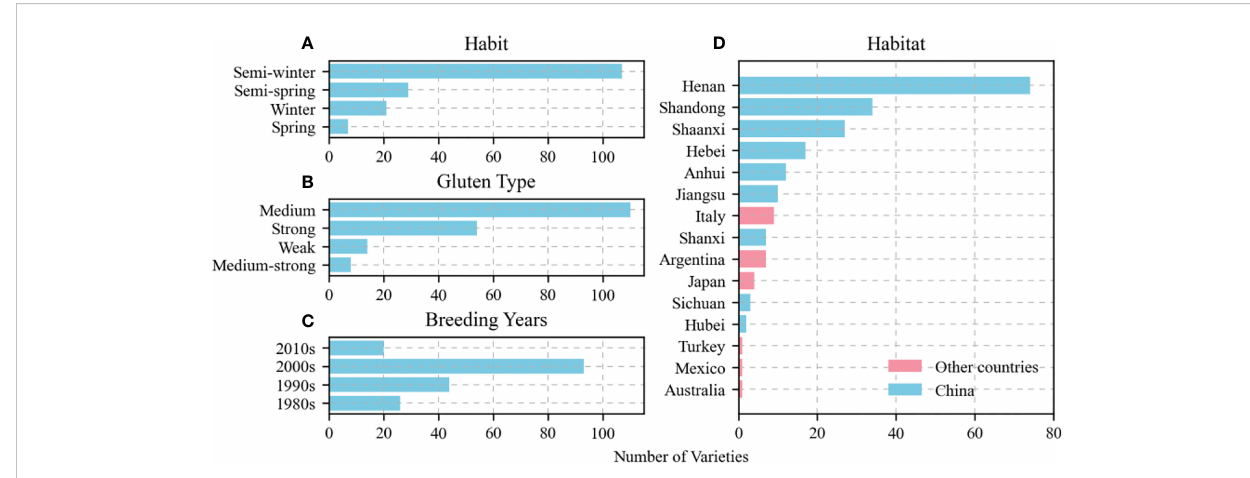
FIGURE 1 Distribution of tested varieties in terms of habit (A) , gluten type (B) , breeding year (C) , and habitat particularly among nine provinces in China (D)